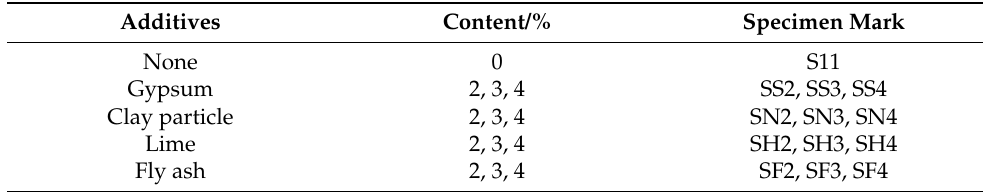
Table 3. Mixture proportions varying